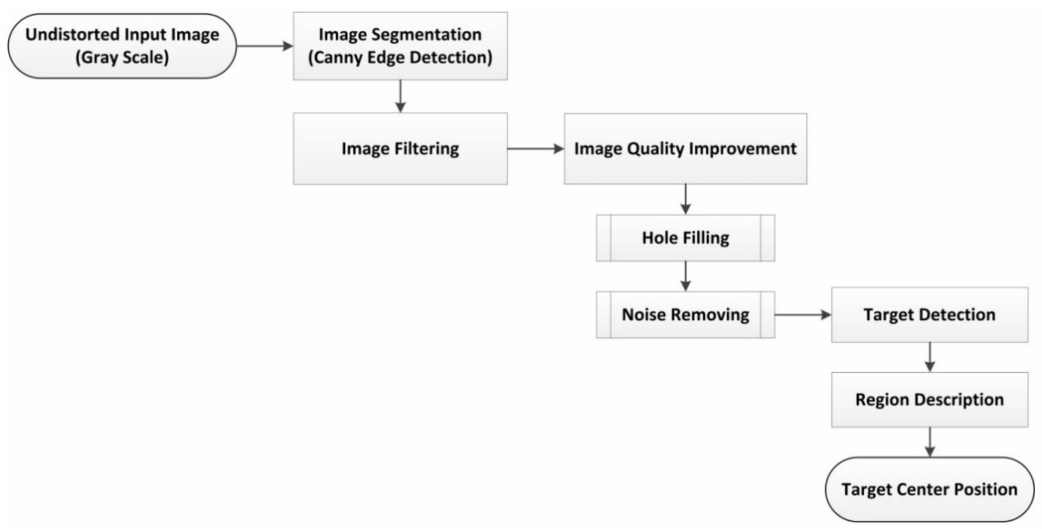
Figure 2. Flowchart of the image processing and analysis